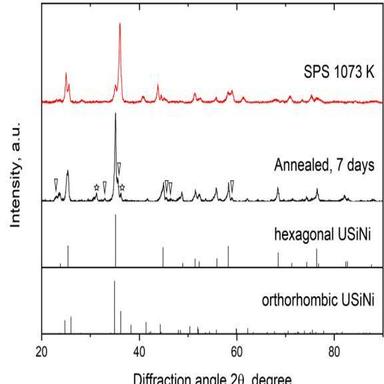
XRD patterns of the USiNi sample after SPS and annealing for seven days, with reference patterns for hexagonal and orthorhombic USiNi.